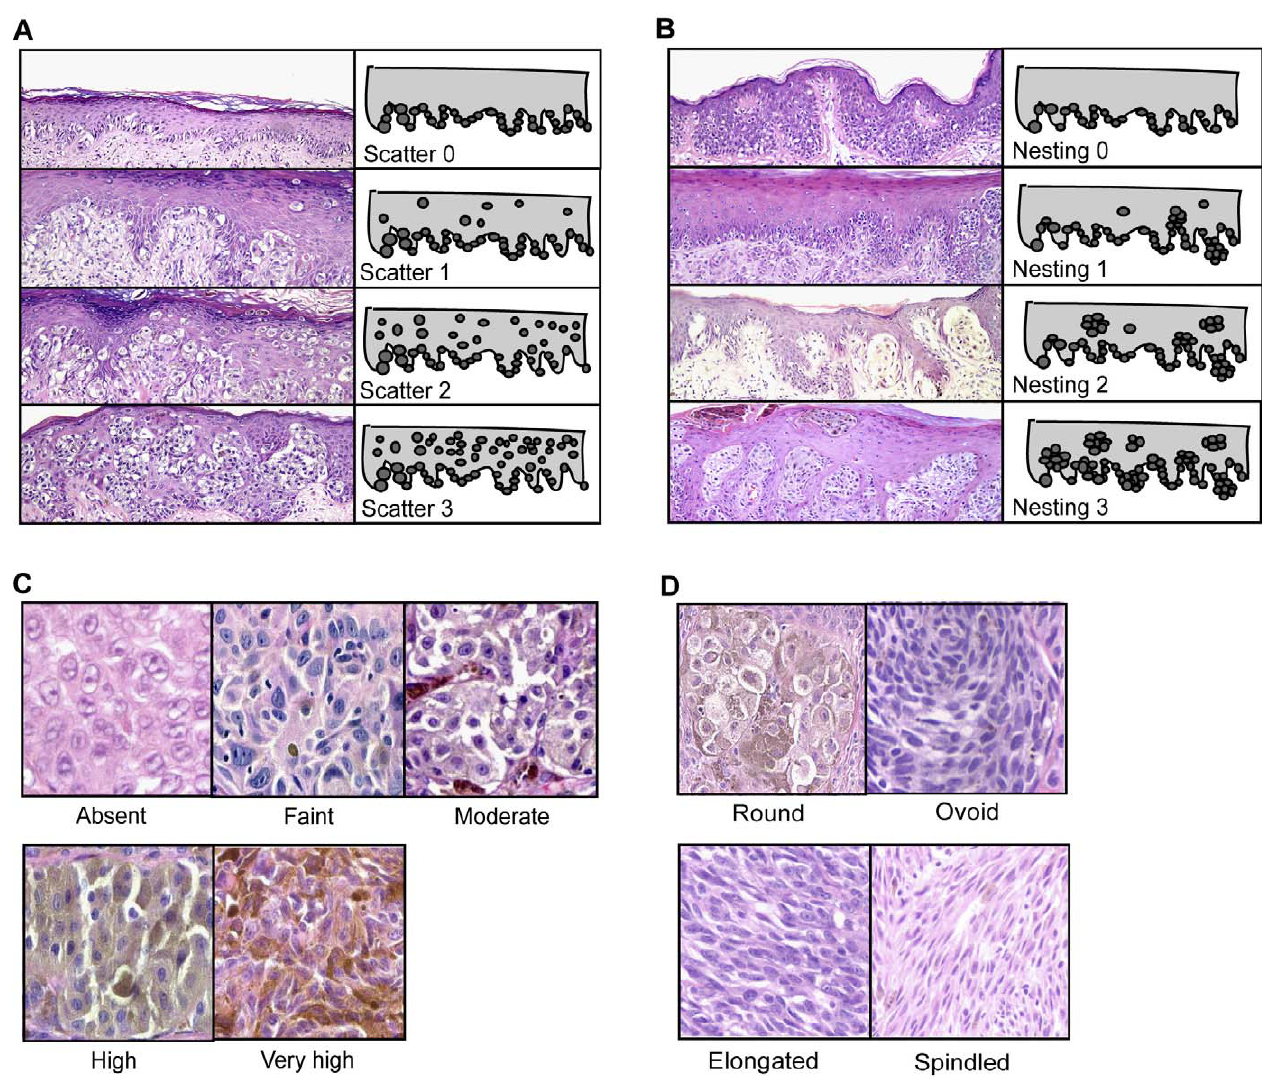
Figure 1. Grading of Morphological Features (A) Scatter of intraepidermal melanocytes. (B) Nesting of intraepidermal melanocytes. (C) Cytoplasmic pigmentation of neoplastic melanocytes. (D) Cell shapes. (Figure 1A) using the following criteria: 0, essentially all melanocytes situated at the dermo-epidermal junction, with only rare melanocytes in higher epidermal layers; 1, the majority of melanocytes (75%–100%) situated at the dermo- epidermal junction, with some present in higher epidermal layers; 2, roughly equal proportions of intraepidermal melanocytes present at the dermo-epidermal junction and in higher epidermal layers; 3, most ( . 50%) of the intra- epidermal melanocytes situated in the upper layers of the epidermis